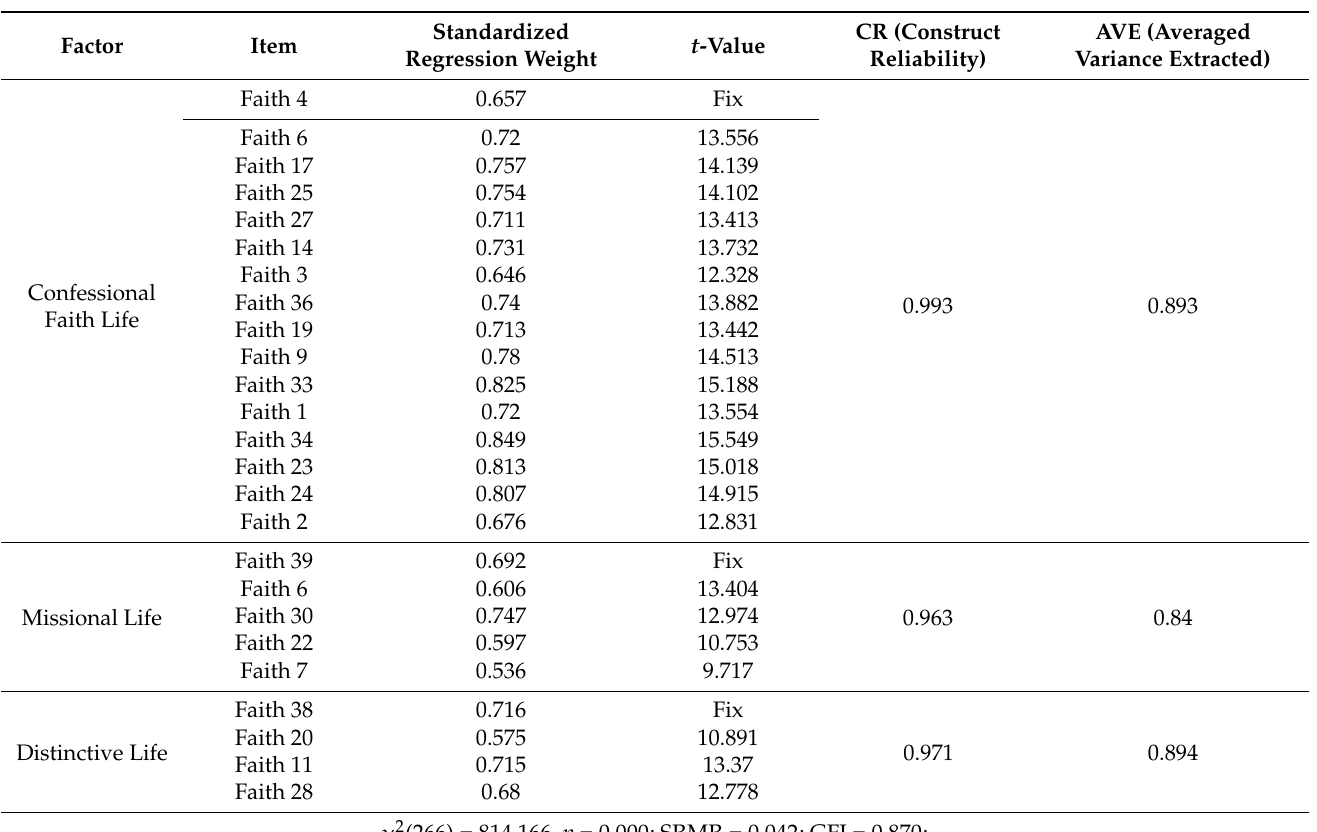
Table 3. Convergent